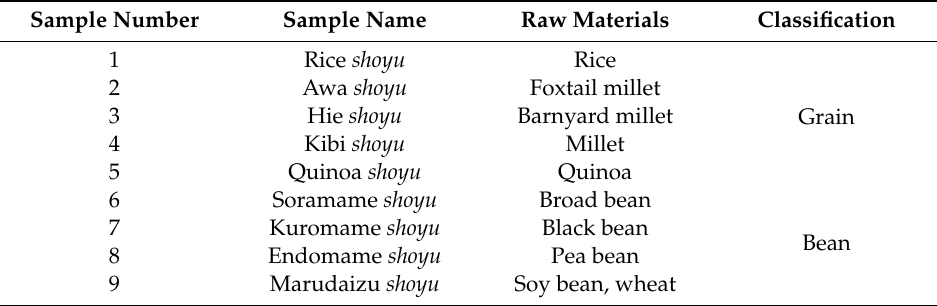
Table 5. Soy-sauce-like seasoning sample